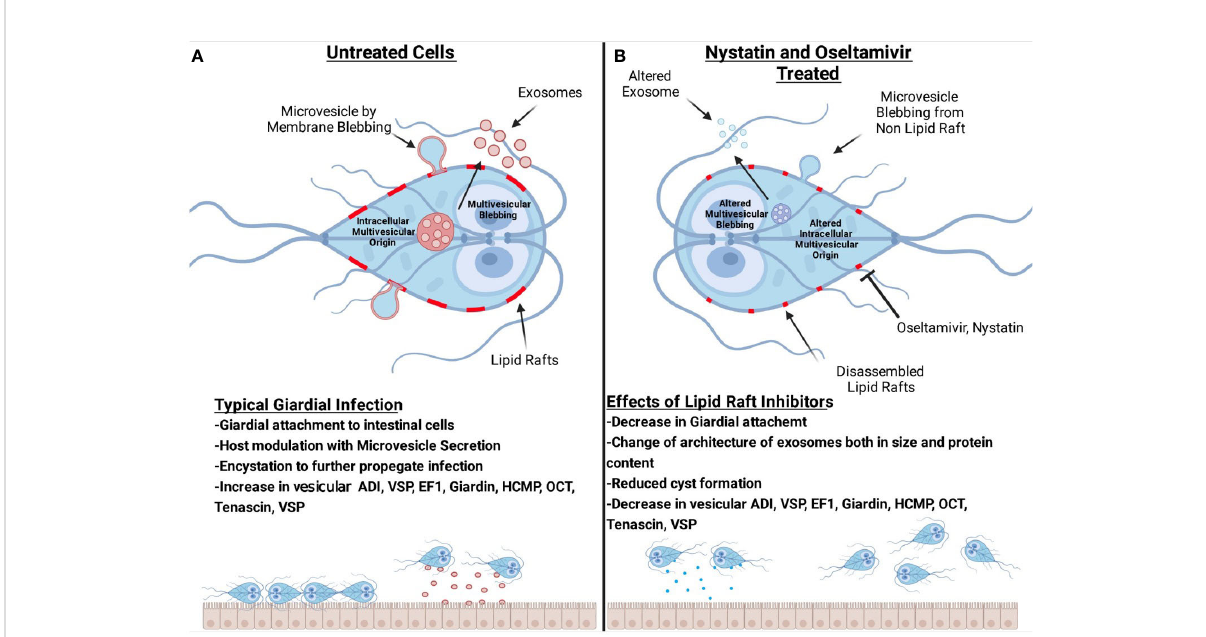
FIGURE 11 Hypothetical models representing the interplay among lipid rafts, microvesicles-like large vesicles, exosomes-like small vesicles and intestinal cells. Panel (A) shows the blebbing of large vesicles from raft- and non-raft membranes of trophozoites. The release of small vesicles is also shown. Our results suggest that lipid rafts support the attachment of trophozoites on host cells and produce infection. Vesicles are secreted by this parasite to modulate host response and the breakdown of intestinal cellular integrity. Panel (B) shows that both oseltamivir or nystatin disrupts rafts and affects large as well as small vesicles. The architecture, size, and composition of vesicles, speci fi cally the small vesicles are severely affected by these compounds. Lipid raft disruptors reduce the overall number of virulence factors present in vesicles. Oseltamivir and nystatin disrupt raft domains and decrease the ability of Giardia to attach to intestinal cells, encyst and producing infection in mice. (The image was created with